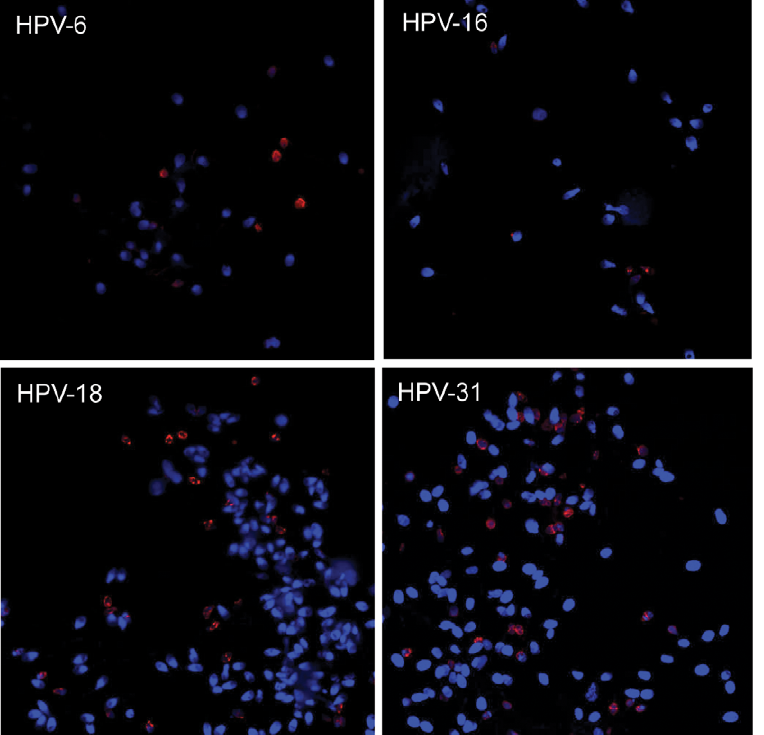
Figure 5. Frequency of HPV-positive sperm using fluorescence in situ hybridization with HPV type-specific probes. Low magnification pictures illustrating the quantity of HPV in positive semen samples. Samples are positive for HPV-6, -16, -18, and -31, respectively. Samples are stained for HPV with PE-conjugated streptavidin (red) and stained for DNA with DAPI (blue). Pictures are representatives of coincidental spots of the preparation slides, which are representatives of HPV positive semen samples from 9 donors (HPV-6, -16, -18, and -31 represented by 2–3 donors each).